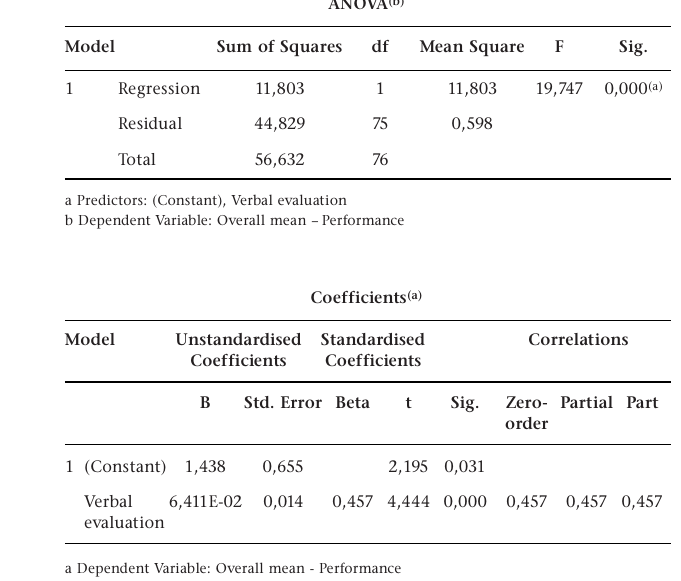
a Dependent Variable: Overall mean -